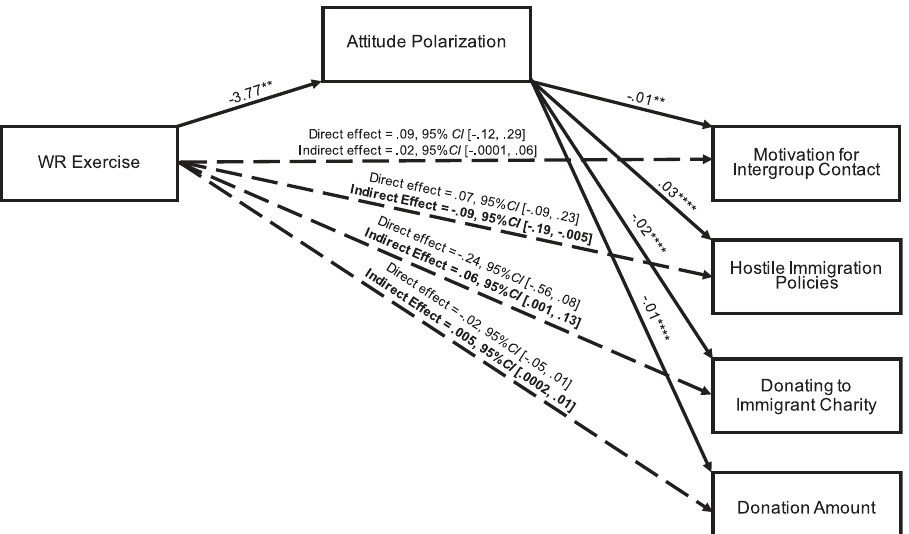
Fig. 5 Results of Study 6: mediation models with wise reasoning exercise as the predictor, attitude polarization as the mediator, and outcome variables as the criterion variables. Unstandardized coef fi cients. Mediation tests were conducted separately — graphics are condensed for simplicity. Signi fi cant indirect effects are